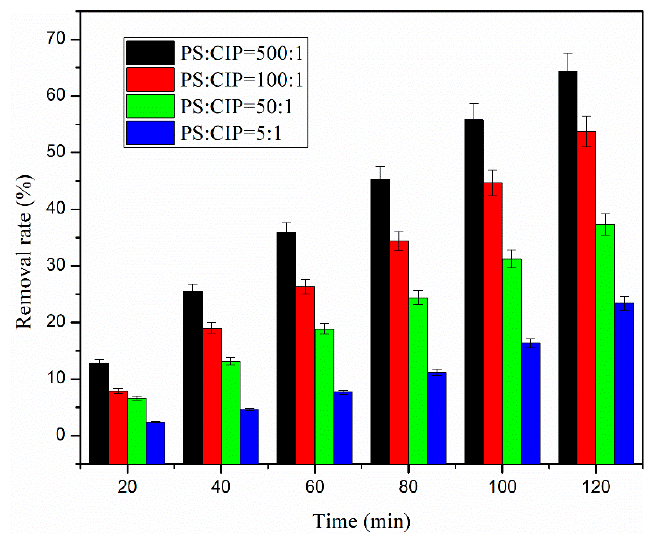
Figure 8. Effects of initial concentration ratio on removal effect of